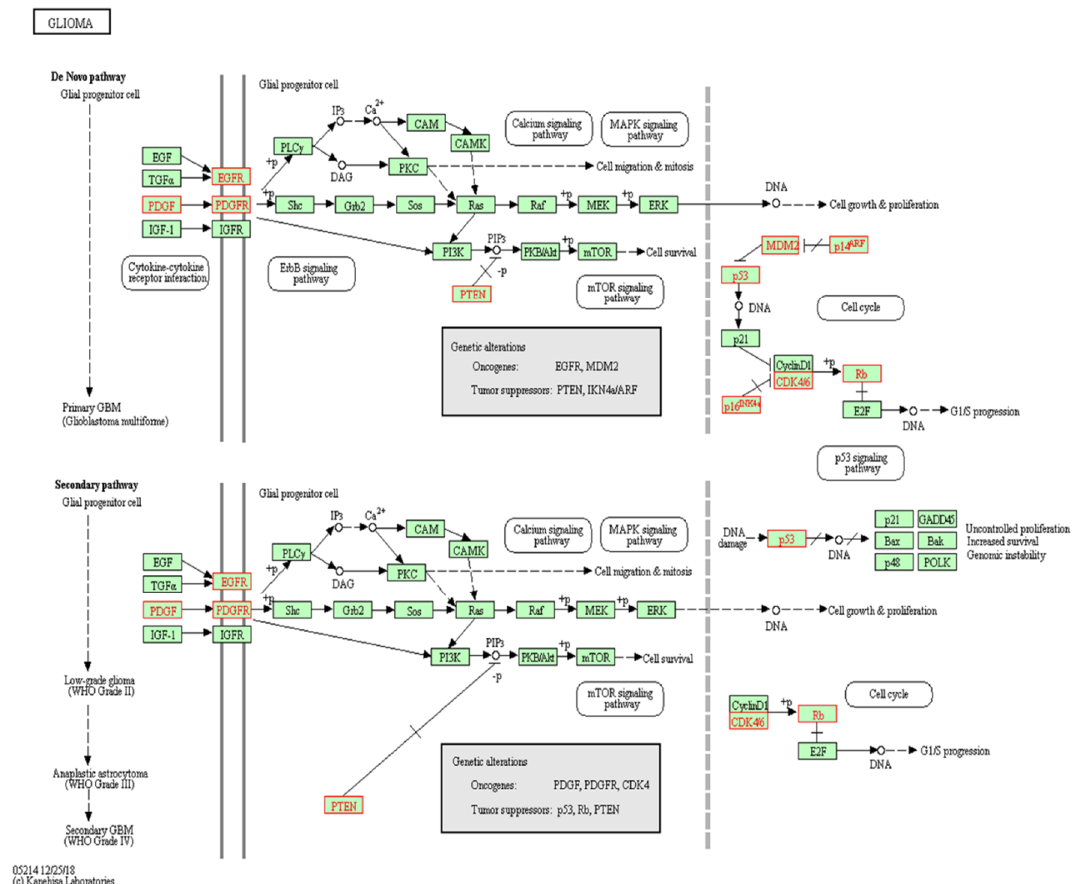
Figure 2. Genetic alteration pathways of GBM. Gene pathways related to pathogenesis in primary and secondary GBM (map05214). The data was derived from the Kyoto Encyclopedia of Gene and Genomes (KEGG) database [26–28]. Genomes (KEGG) database